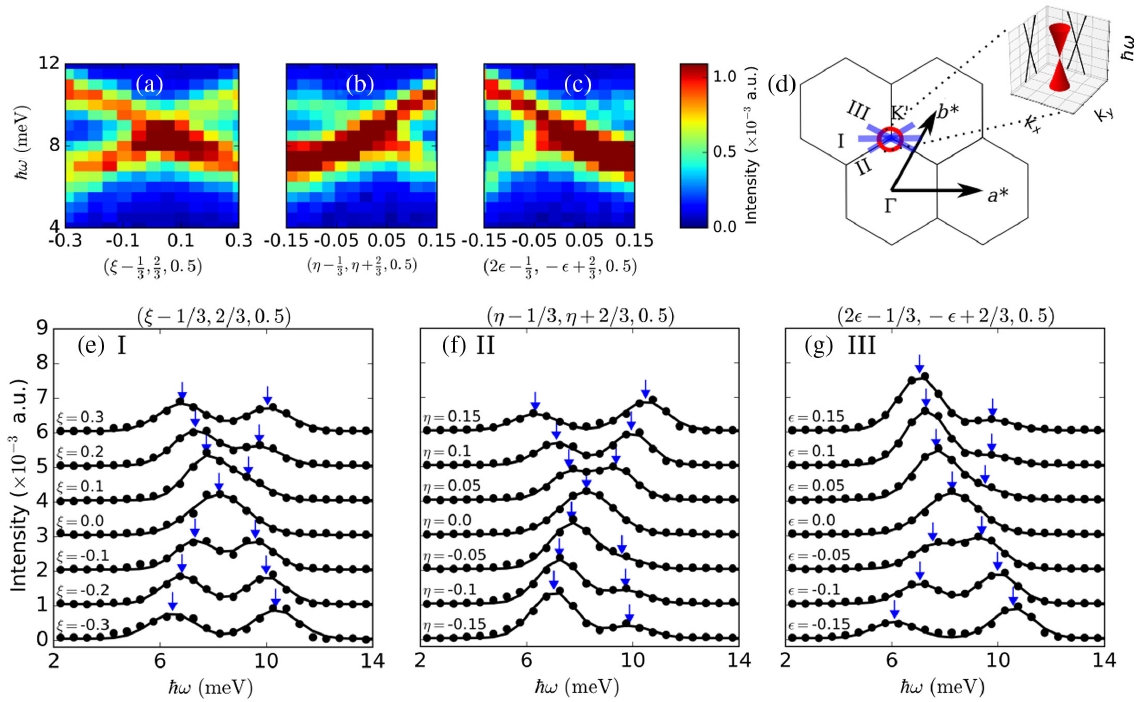
Þ along different momentum cuts indicated in panel (d), which lie in the ( H; K ) ; 2 FIG. 4. (a) – (c) Magnon spectra close to K 0 ¼ ð − 1 3 3 Þ , (II) ð η − 1 Þ , and (III) ð 2 ϵ − 1 Þ . (d) BZ in the ( H; K ) plane, with the directions of I – III ; 2 ; η þ 2 ; − ϵ þ 2 plane (with L ¼ 0 . 5 ): (I) ð ξ − 1 3 3 3 3 3 3 indicated by thick blue bars. The Dirac point K 0 is denoted by a red circle [same as in Fig. 3(l)]. The Dirac cone near K 0 is shown schematically in the inset. Cuts through different directions, which all pass through the Dirac point, should show an X-shaped dispersion (black solid line) where the magnon modes cross only at the Dirac point. (e) – (g) Measured intensity versus energy at fixed momentum along I – III, extracted from the magnon spectra in panels (a) – (c), respectively. The plots at different momenta in the same panel have been offset for clarity. Each cut is fit to two Gaussians with the same widths on top of a fixed constant background. Peak positions obtained from the fit are indicated by blue arrows.